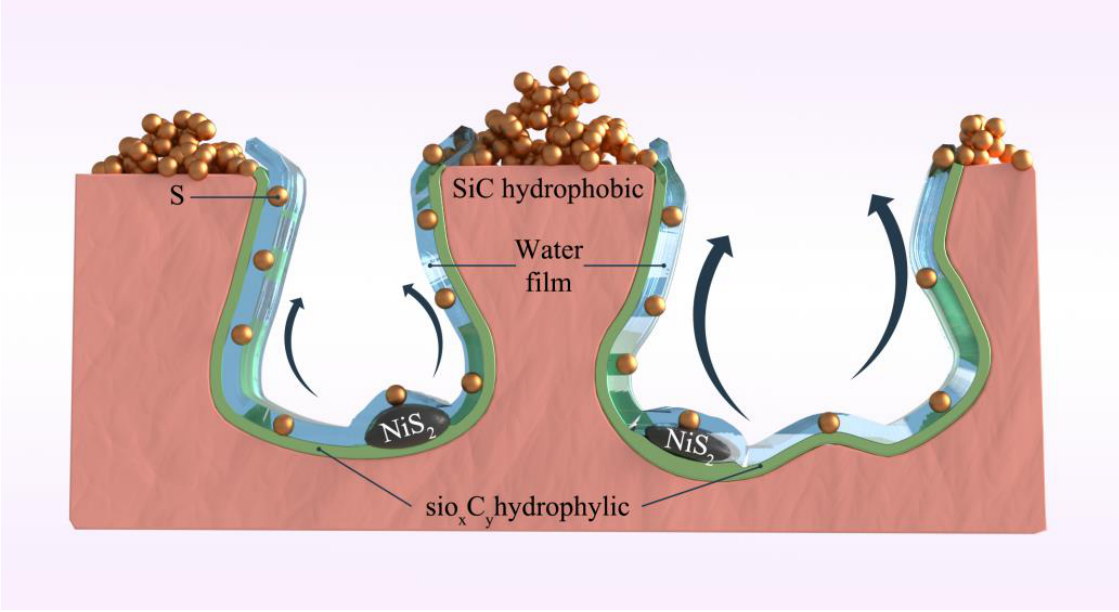
Figure 4. A schematic diagram of the effect of hydrophobic/hydrophilic dual characteristics of the condensate and SiC on the sulfur deposition mode. Adapted with permission from Ref. [46]. 2002, Elsevier Science B.V.